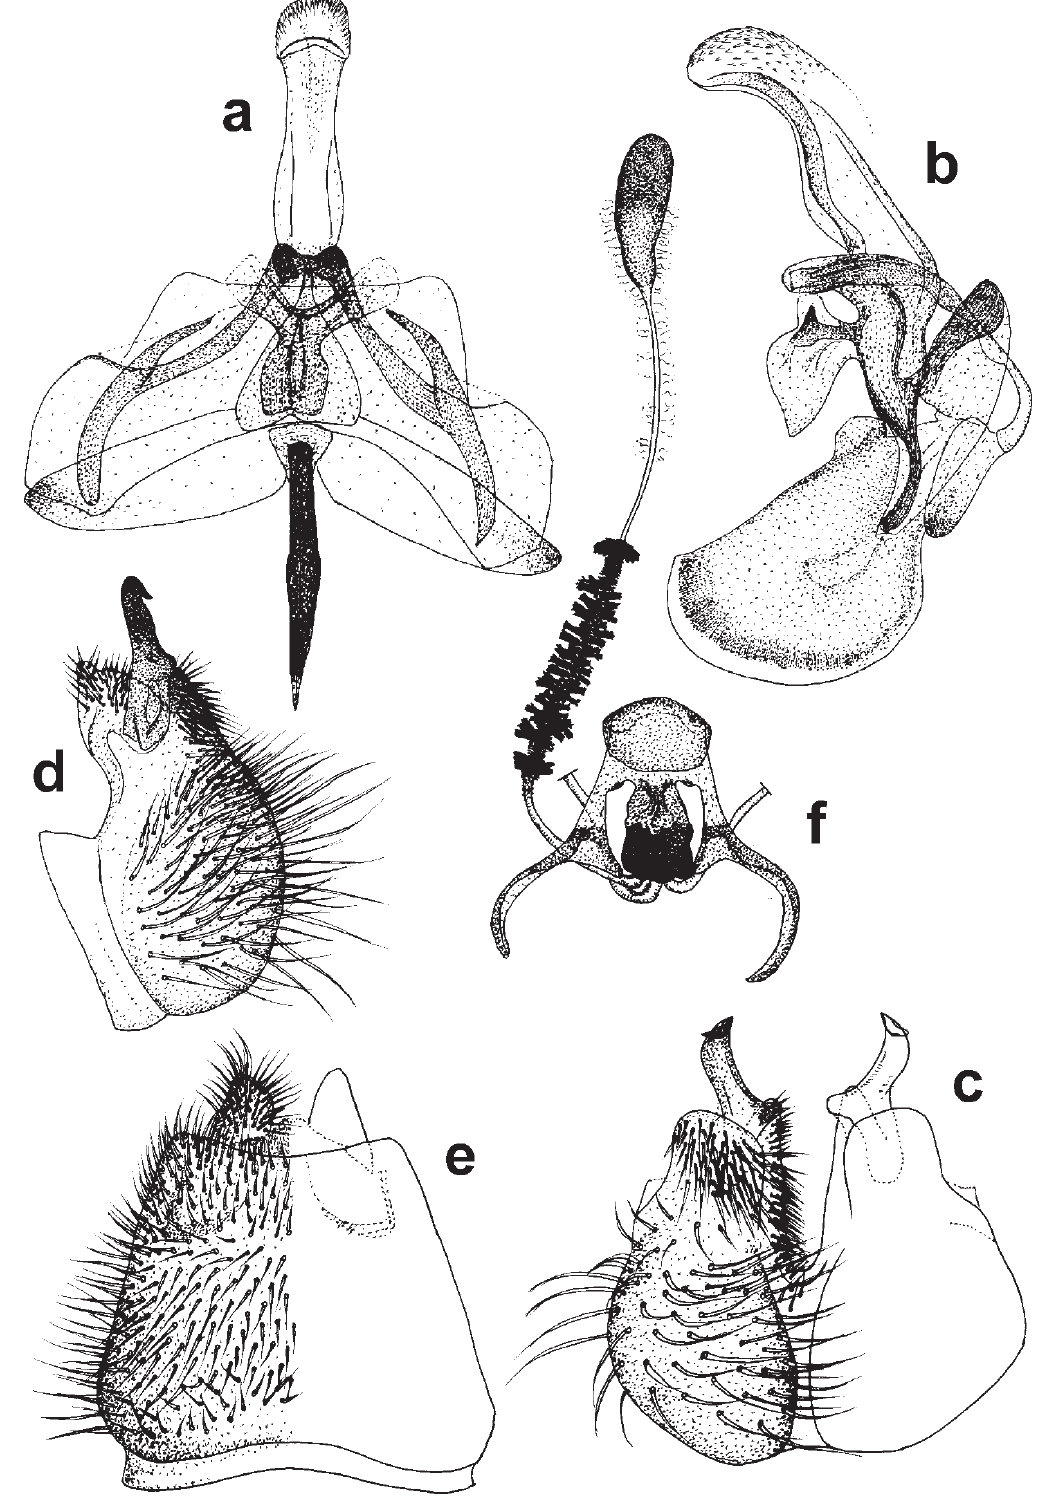
Fig. 59. Protypusia zimini (Paramonov, 1947) gen. et comb. nov. a . Epiphallic complex ventral. b . Epiphallic complex lateral. c . Gonocoxite ventral. d . Gonocoxite lateral. e . Epandrium dorsal. f . Female genitalia